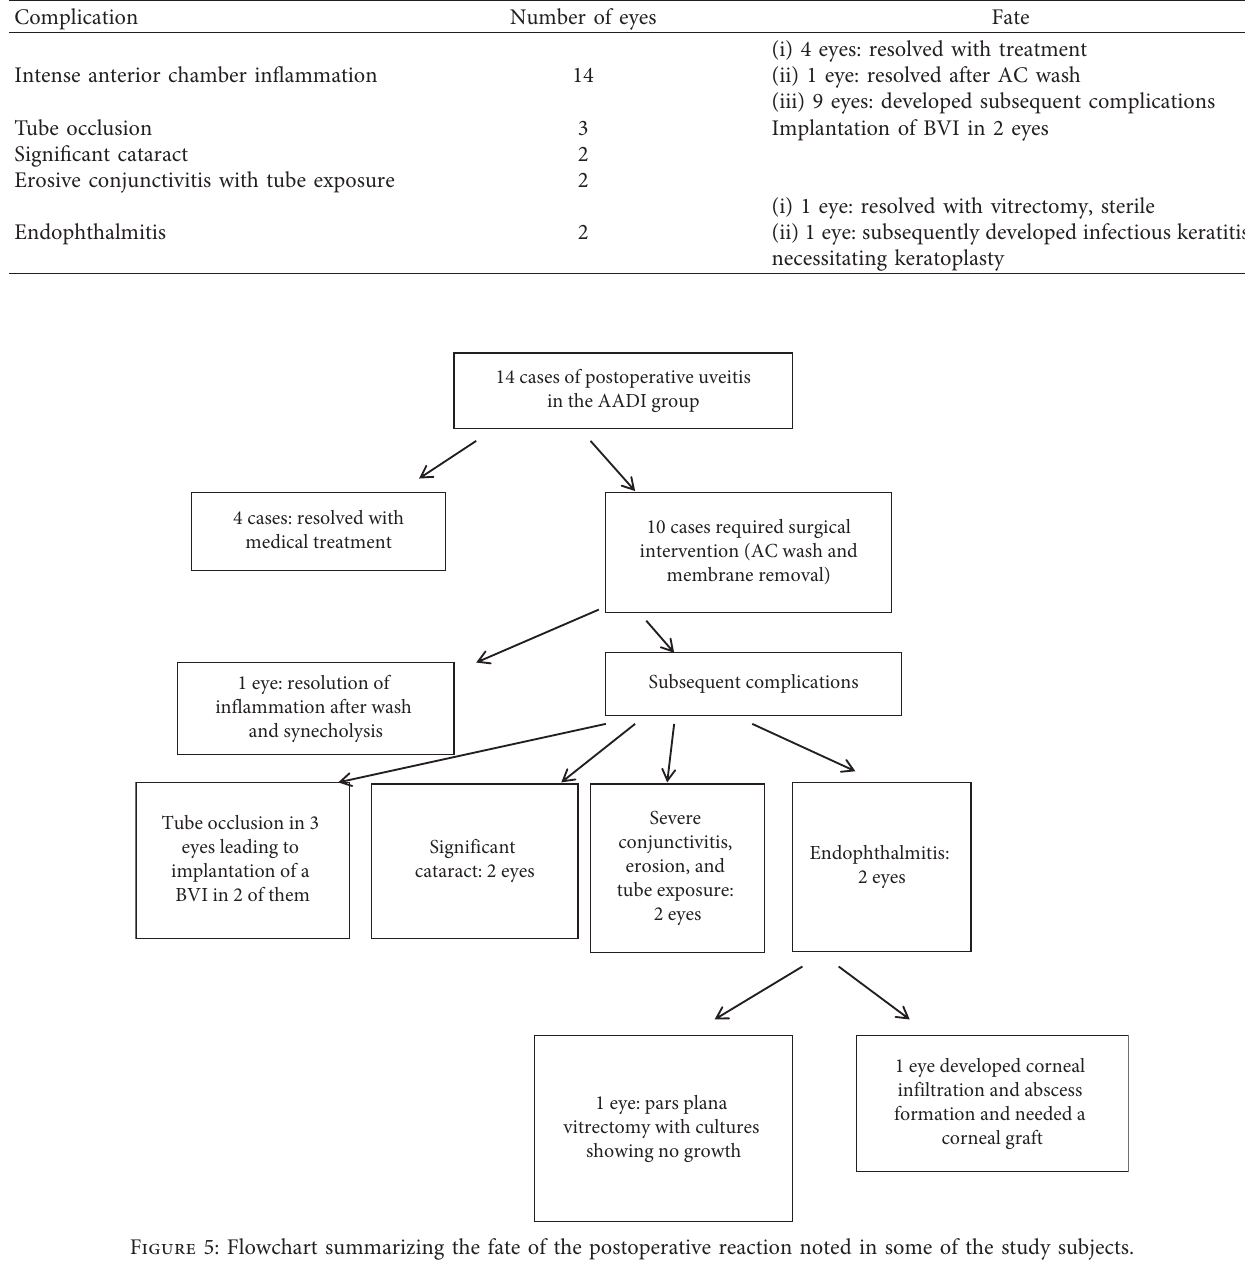
Table 3: Complications seen in eyes which received AADI implant.